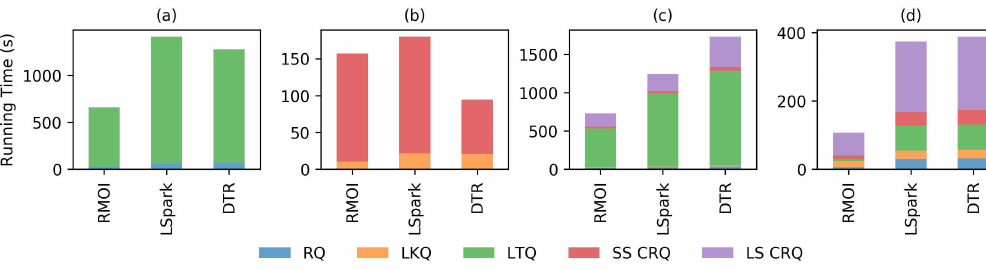
Figure 12. Stress testing on the UK + IE dataset with high resource availability on ( a ) 1st query set with 2 QTs, ( b ) 2nd query set with 2 QTs, ( c ) 3rd query set with 5 QTs, and ( d ) 4th query set with 5 QTs.